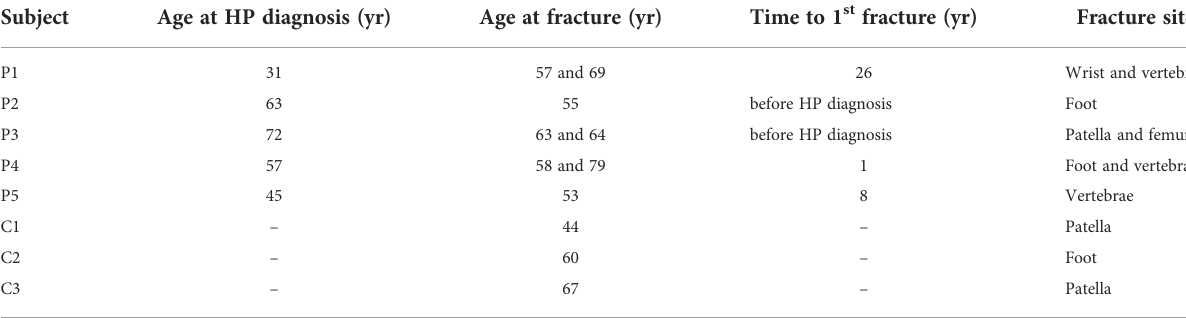
TABLE 5 Clinical fragility fractures in patients with postsurgical hypoparathyroidism and